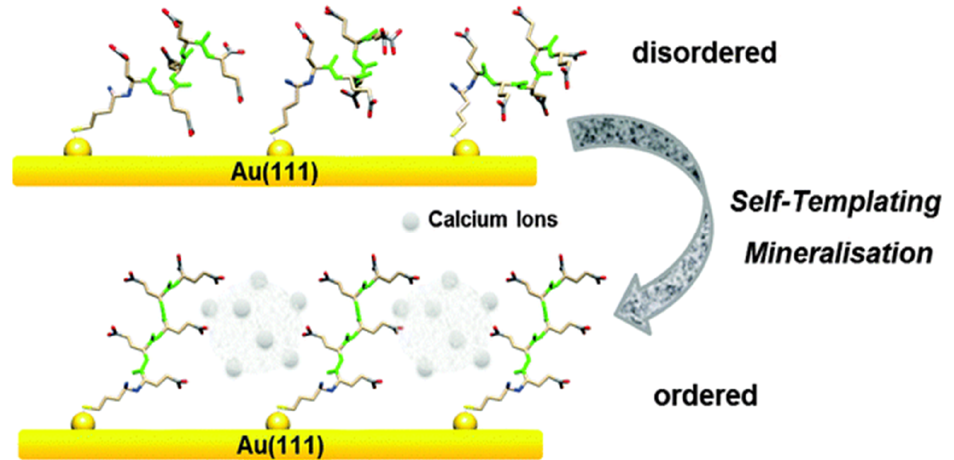
Figure 1. Schematic drawing of Glu5 peptide layer on Au when interacting with CaCO 3 precursors. This Figure is adapted with permission from [31].